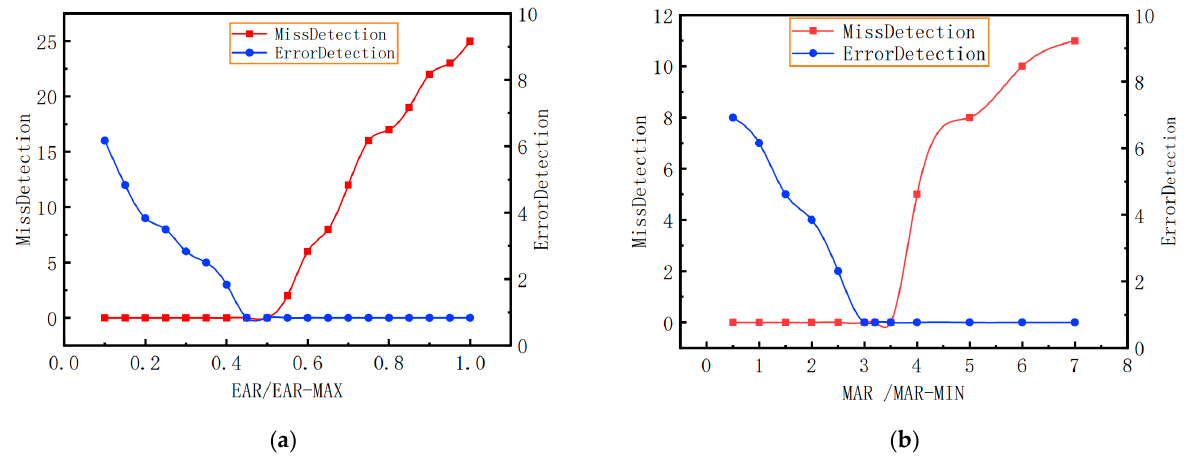
Figure 10. Wrong and missed detection experiments for different ratios: ( a ) shows the wrong and missed detection images under the different EAR and EAR-MAX , and ( b ) shows the wrong and missed detection images under different MAR and MAR-MIN.